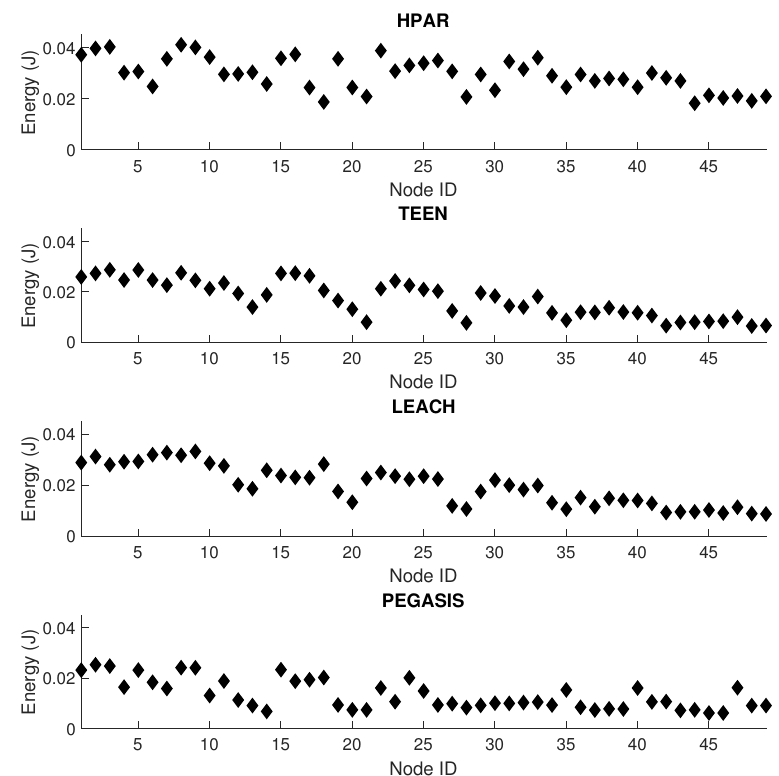
Figure 15. Energy per node for simultaneous conditions of interference and